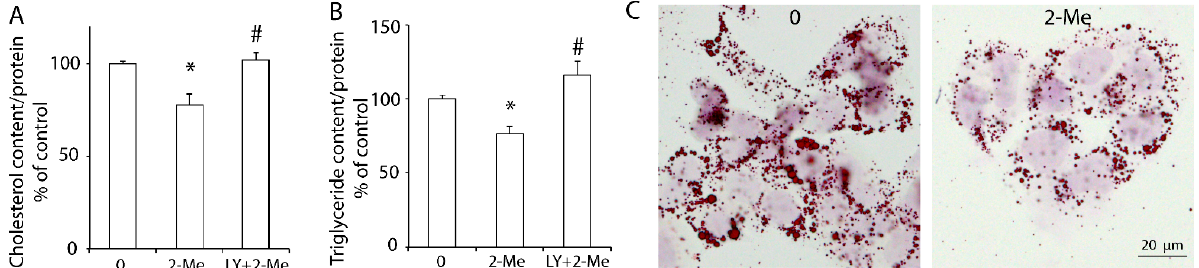
Figure 3. 2-ME 2 decreases the lipid content in HepG2 cells via the PI3K pathway. Cholesterol content ( A ), triglyceride content ( B ), or Oil Red O staining ( C ) in HepG2 cells with varying treatments. The cholesterol content was normalized by the protein concentration. 2-ME 2 , 2-ME 2 at 1 µ M; LY, PI3K inhibitor LY294002 at 10 µ M. The results are represented as the mean ± SEM ( n = 3) of separate experiments for each group. * p < 0.05 compared to control; # p < 0.05 compared to 2-ME 2 .